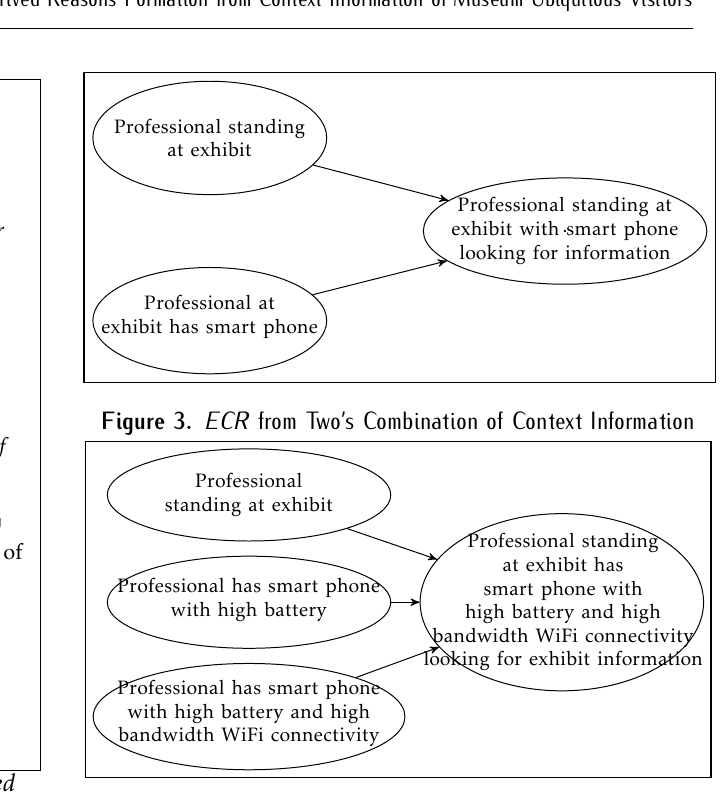
Figure 4. ECR from Three’s Combination of Context